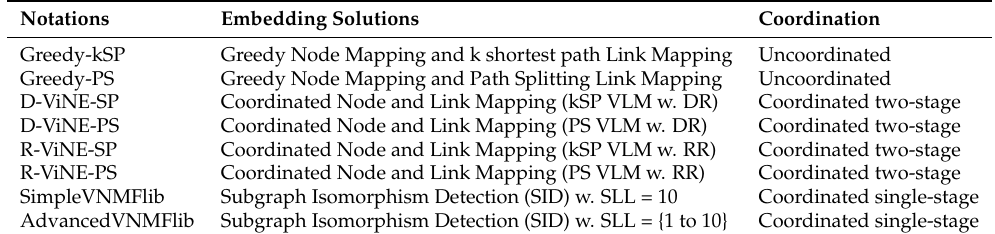
Table 2. Examined mapping